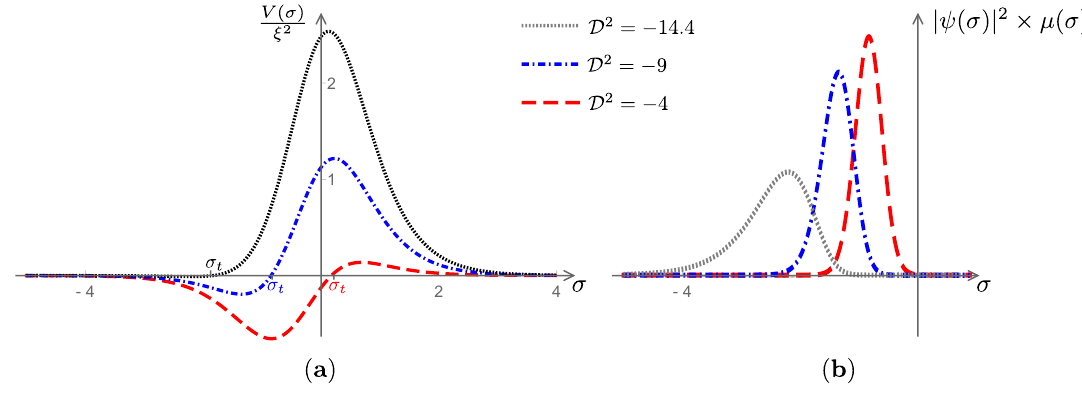
Figure 12 . ( a ) The typical shape of the strong coupling potential (4.34), drawn here for ( (cid:18) 1 ; (cid:18) 2 ) = (4 = 3 ; 1 = 2), zero spins and D 2 = (cid:0) 4 (red), D 2 = (cid:0) 9 (blue), D 2 = (cid:0) 14 : 4 (black). At large coupling, the potential becomes very high and the wave function is localised, with the